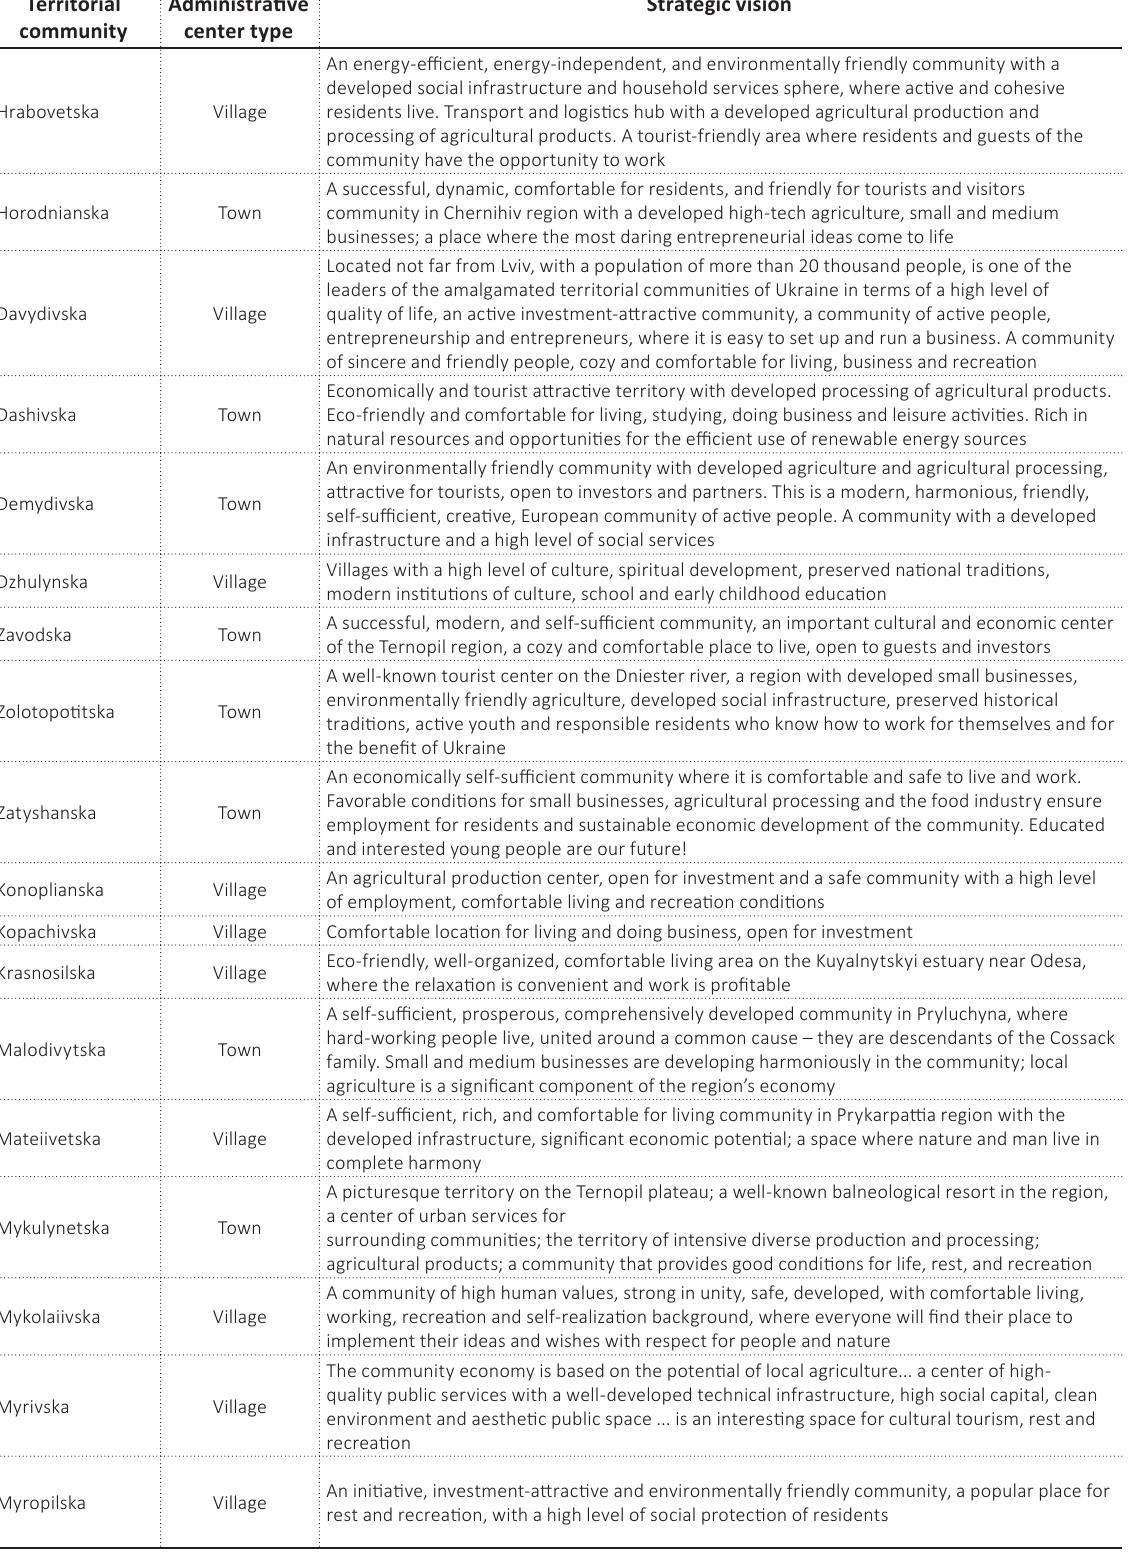
Table A1 (cont.). Strategic visions of the studied